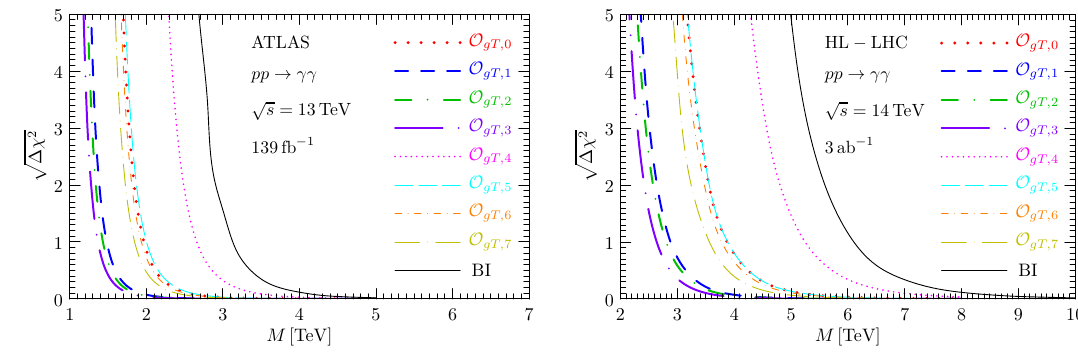
p Figure 4 . The significances ∆ χ 2 for probes of the individual dimension-8 gQGC operators O gT,i and their Born-Infeld combination in eq. (2.5) at the LHC as functions of the cut-off scales M i . √ These results are obtained from the gg → γγ reaction at s = 13 TeV with integrated luminosity √ L = 139 fb − 1 observed by ATLAS (left) and s = 14 TeV with L = 3 ab − 1 at HL-LHC